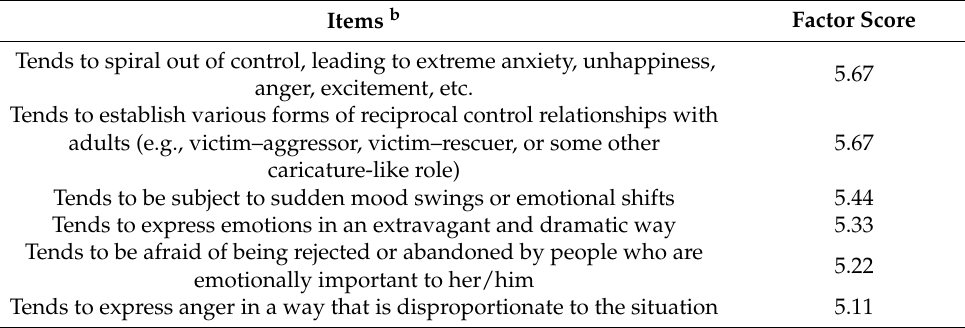
Table 3. Best CPAP-Q a items of the borderline/dysregulated prototype. Items b Factor